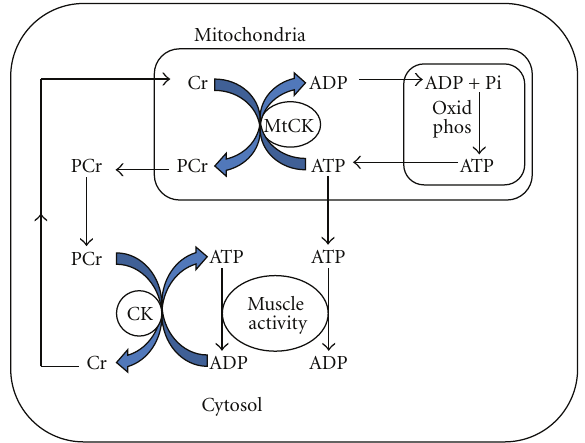
Figure 1: Phosphocreatine (PCr) circuit showing the rephosphory- lation of creatine (Cr) in mitochondria using ATP derived from oxidative phosphorylation (oxid phos) and subsequent use of mito- chondrial PCr by cytosolic creatine kinase (CK) to resupply ATP for muscle activity, adapted from Saks